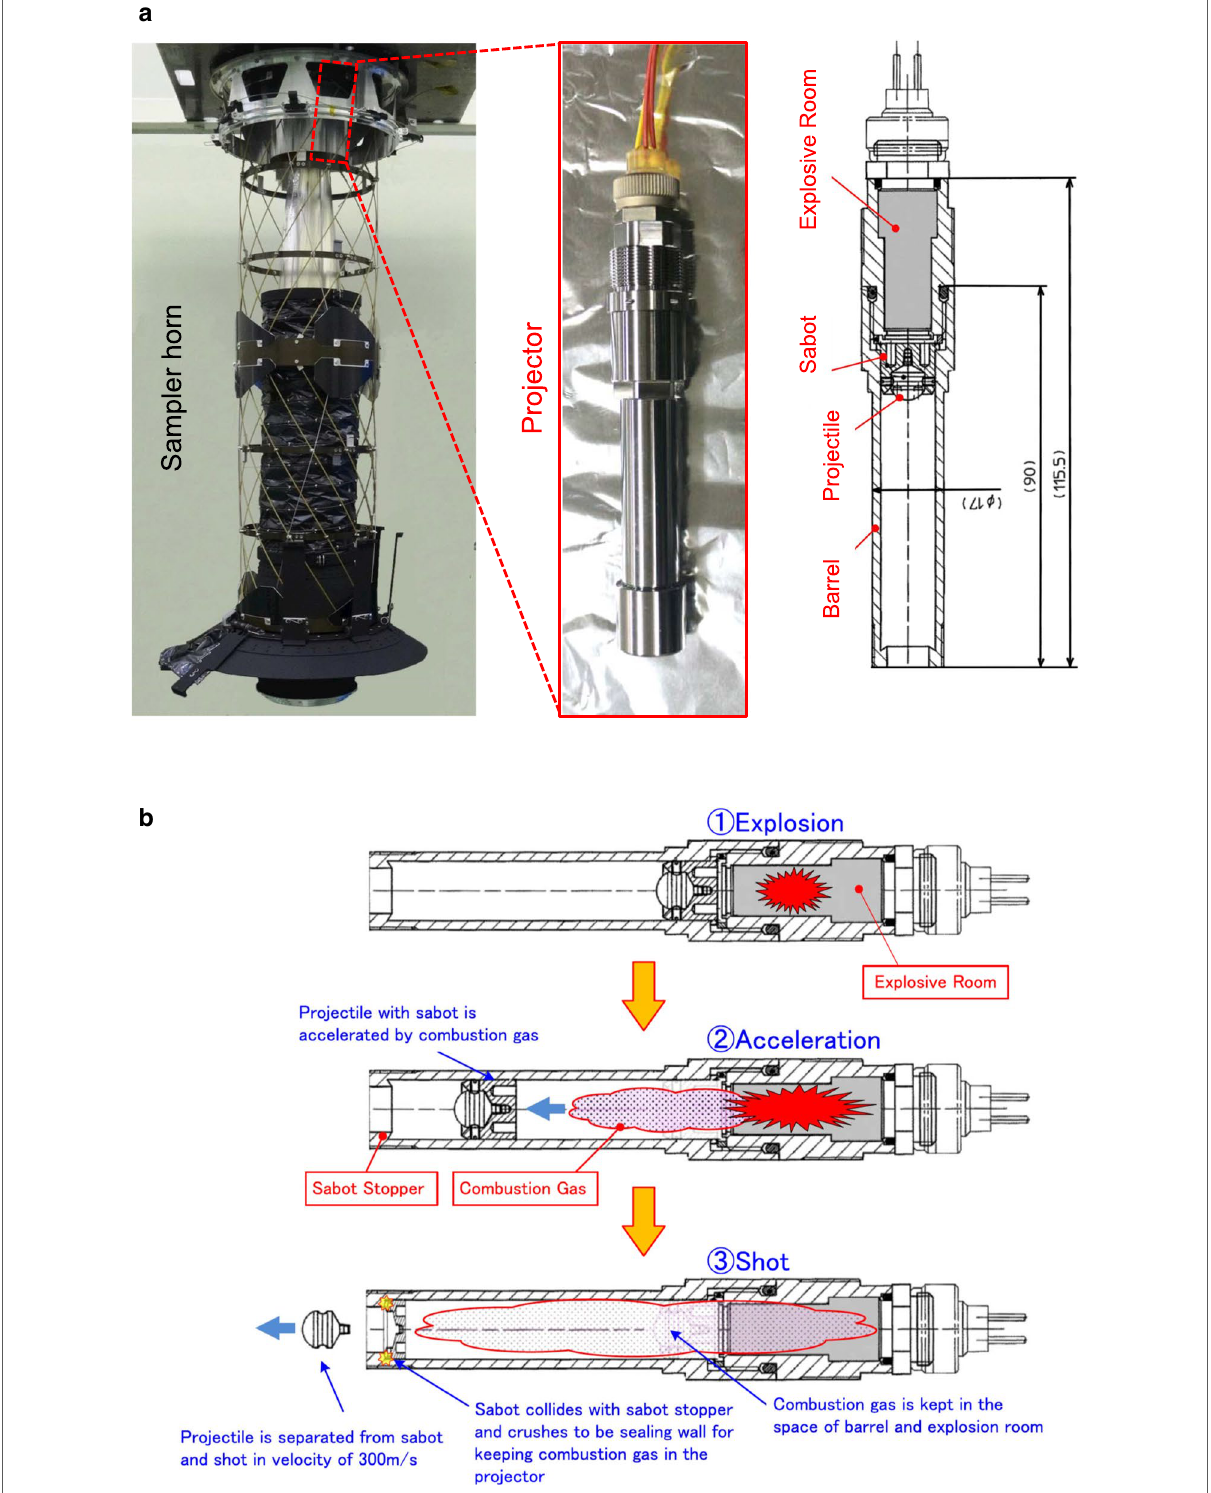
Fig. 1 a Photograph of the Hayabusa2 sampler horn (Tachibana et al. 2014) and projector system with a schematic diagram showing the structure of the barrel, projectile, sabot, and explosive chamber (Sawada et al. 2017). b Schematic representation of the shooting operation of the projector system showing (1) the explosion, (2) acceleration, and (3) shot of the